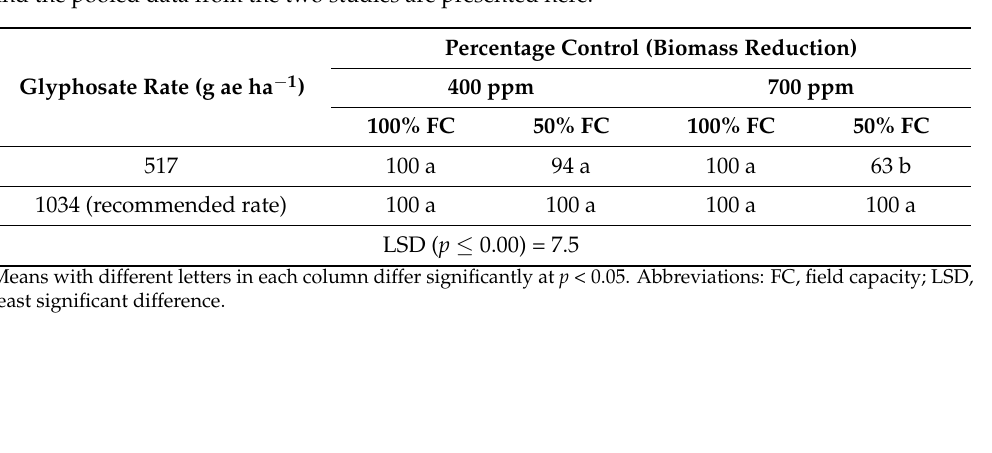
Table 1. Effect of different herbicide rates on weed control, as measured by the biomass reduction in S. cannabina under two different [CO 2 ] and soil moisture conditions. The experiment was repeated, and the pooled data from the two studies are presented here.